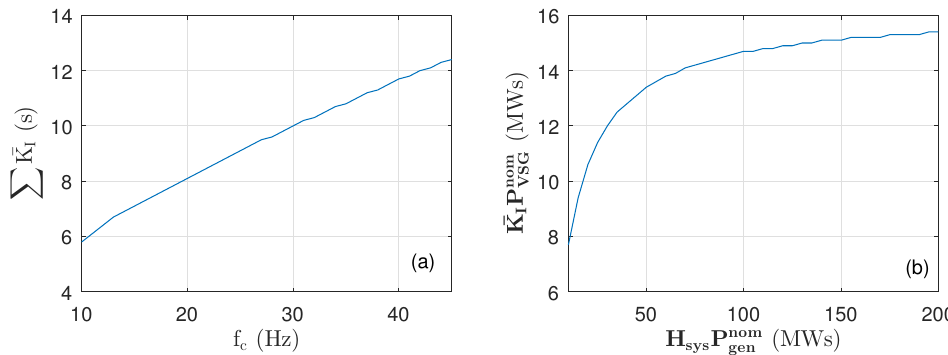
Figure 14. ( a ) Cumulative virtual inertia gain as function of cut-off frequency of PLL and ( b ) Maximum inertia support from VSGs compared to inertia in grid for increasing level of generation